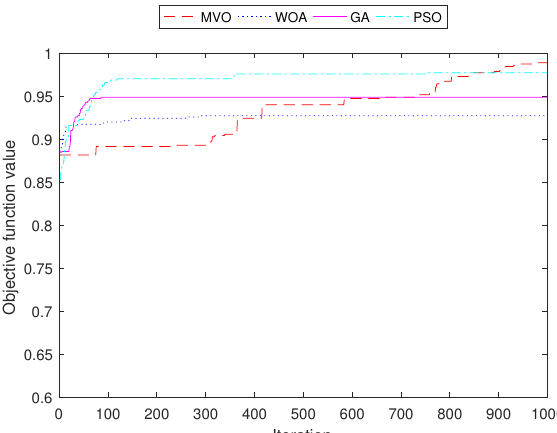
Figure 12. Performance comparison of the objective function value for INS-2 with 40 mesh routers.